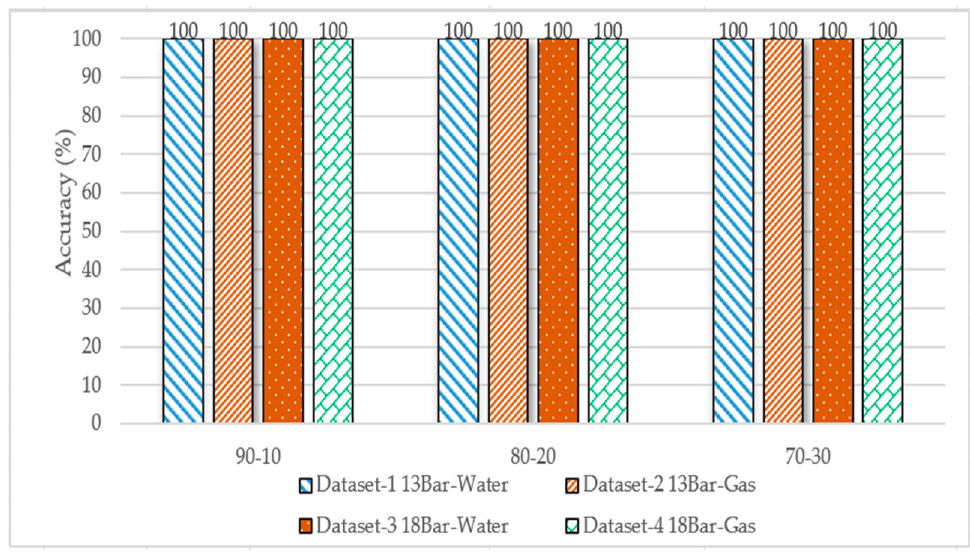
Figure 14. Performance comparison of KNN algorithm accuracy for the four datasets for different data splits.